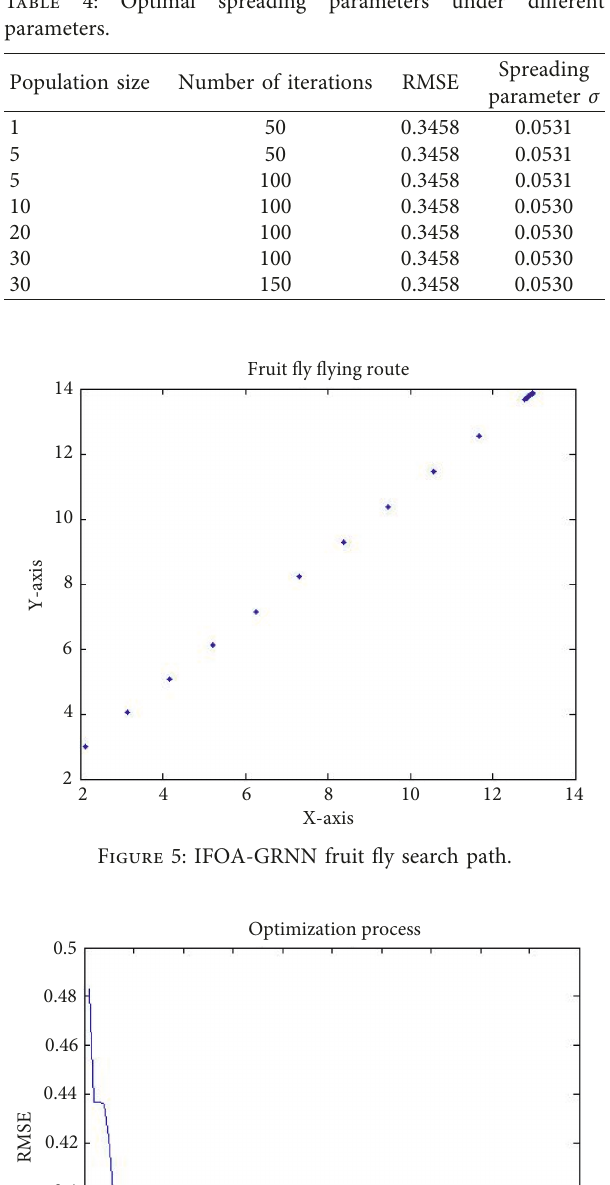
Figure 6. The IFOA-GRNN model finally converged in the ninth iteration after 100 iterations, with a minimum RMSE of 0.3458 and a spreading parameter σ of 0.0530.